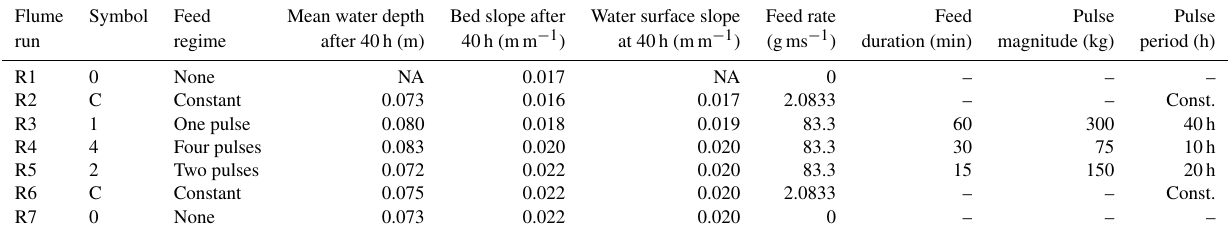
Table 1. Overview of runs in the flume experiments. All runs were 40h long. The texture of the initial bed mixture and the sediment feed were identical. Plots of resulting slope, D sg , D s90 , and sediment transport are shown in Fig. 3. The symbols in column two signify the feed regime where 0 represents no feed, C represents constant feed, and 1, 2, and 4 represent the number of pulses in 40h.